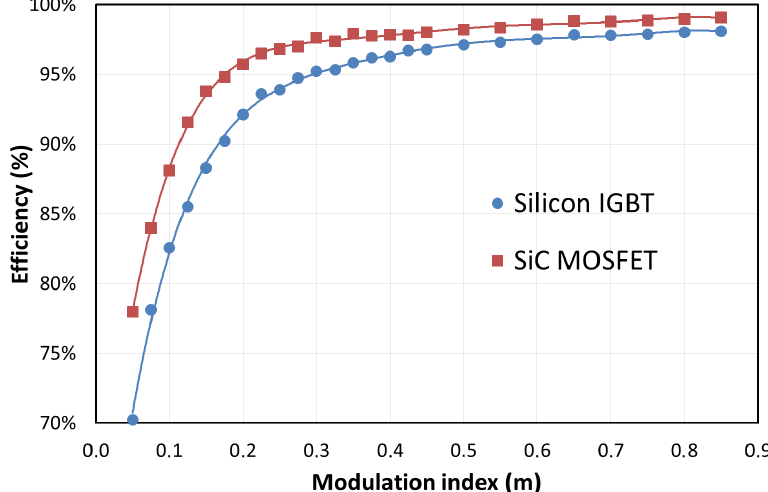
Figure 15. Efficiency comparison with different semiconductors: H6 SVPWM architecture [17].